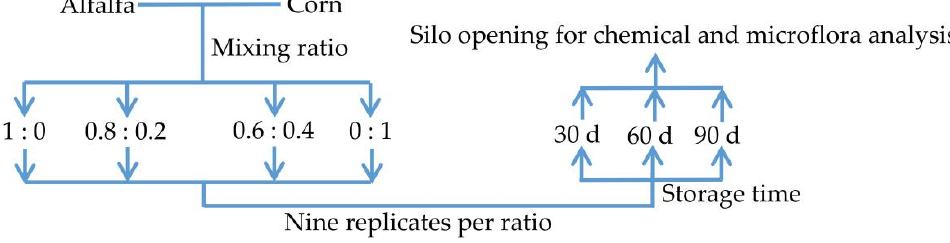
Figure 1. The experimental design and experiment flow diagram .